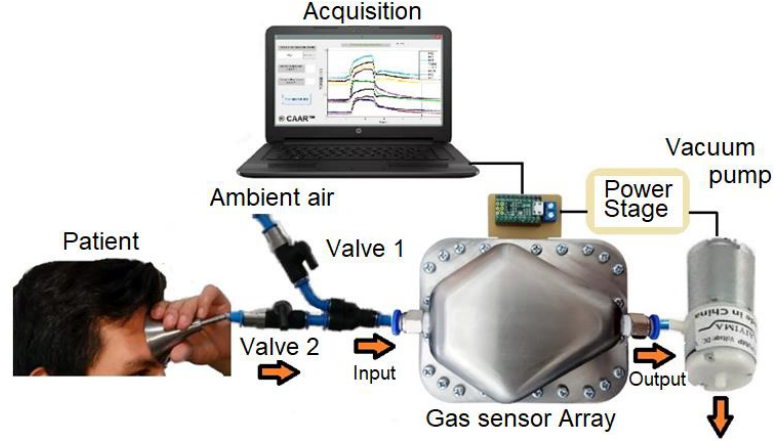
Figure 4. Measurement scheme of Volatile Organic Compounds (VOCs) emitted by the skin through the E-nose.